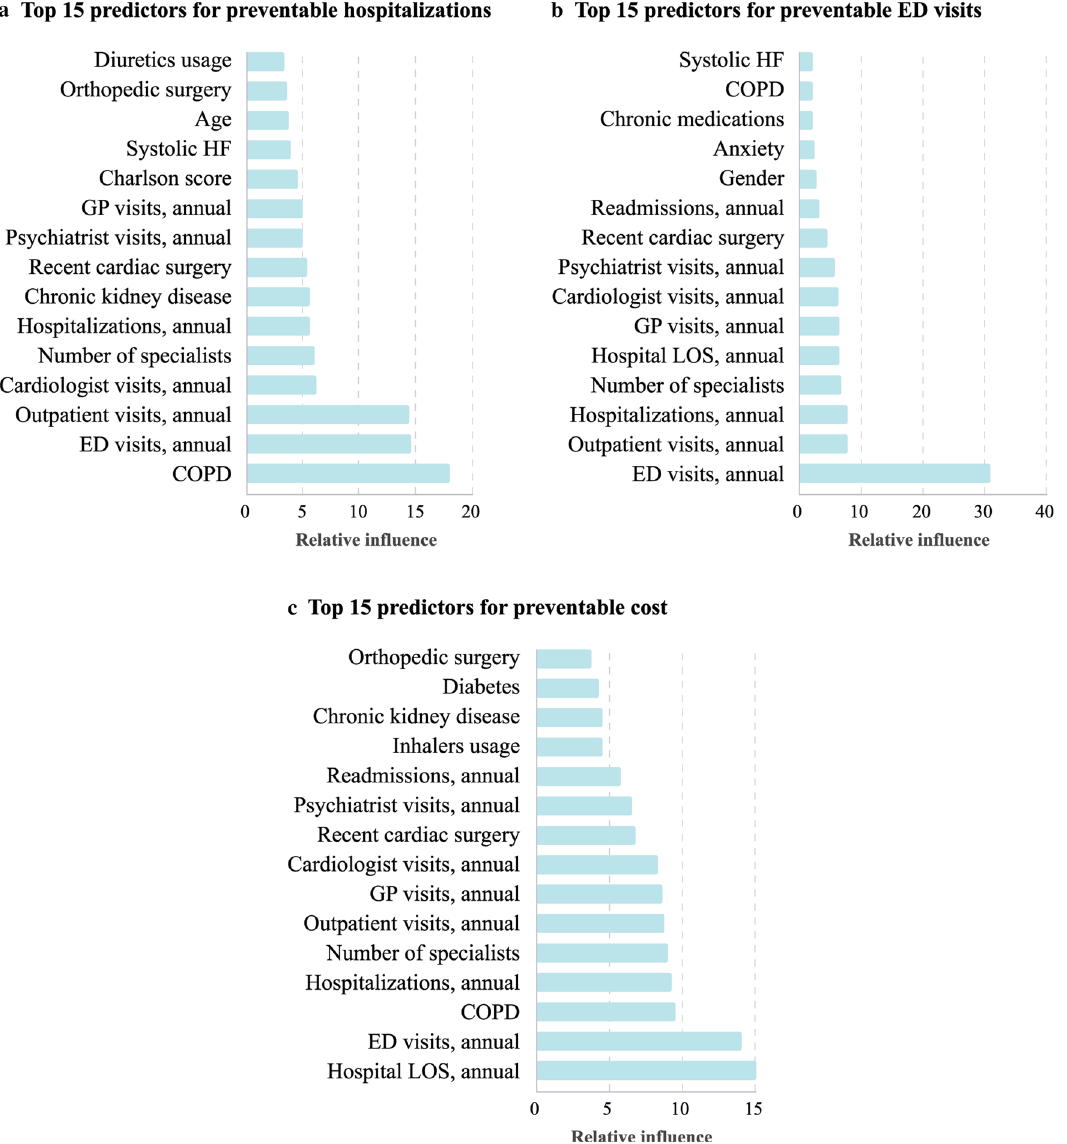
Figure 3. Most Influential Predictors Selected by the GBM for the Prediction of Preventable Hospitalizations, Preventable Emergency Department Visits, and Preventable Costs among Heart Failure Patients. Relative influence values range from 0 to 100 and indicate the relative contribution of a feature in predicting the outcome of interest. Relative influence from the GBM is plotted for the top 15 features of each of the three outcomes. The figure was edited using Adobe Illustrator Creative Cloud version 24.2.1 21 . LOS, Length of Stay; COPD, Chronic Obstructive Pulmonary Disease; ED, Emergency Department; GBM, Gradient Boosting Model; GP, General Practitioner; HF, Heart